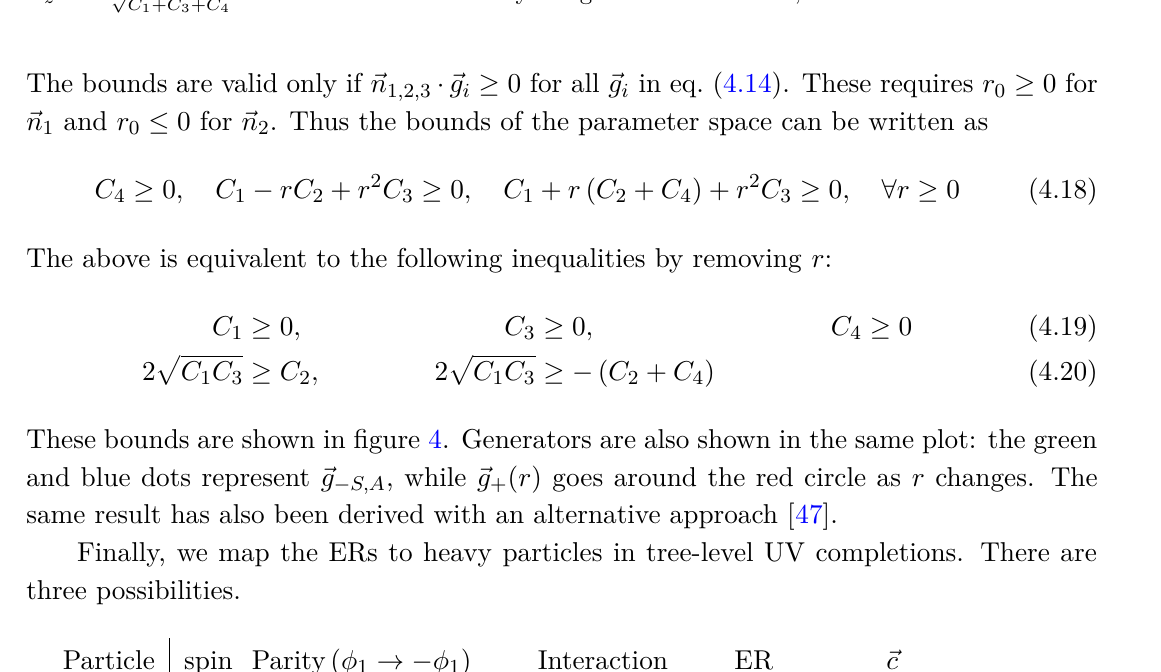
√ √ 3( C 1 − C 3 ) √ = , and 3 C 2 , C y = x C 1 + C 3 + C 4 2( C 1 + C 3 + C 4 )